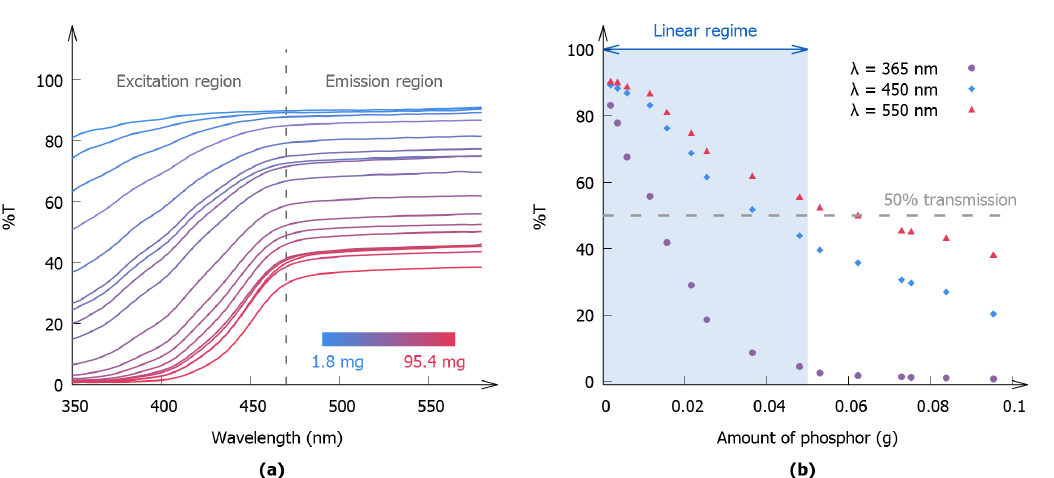
Figure 5. ( a ) Diffuse transmission spectra of polymer layers with different amounts of SrAl 2 O 4 :Eu,Dy incorporated. The plot is divided into a low- and a high-wavelength range, covering the excitation and emission wavelengths of the phosphor, respectively; ( b ) The transmission of the layers at 365 nm, at the excitation wavelength used in this work (450 nm), and at the emission wavelength (550 nm). The linear regime from Figure 3 is indicated as a reference.